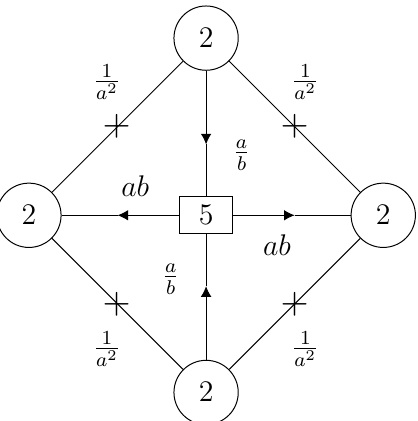
, − 1 , 1 , − 1 ) . The theory also 2 2 2 2